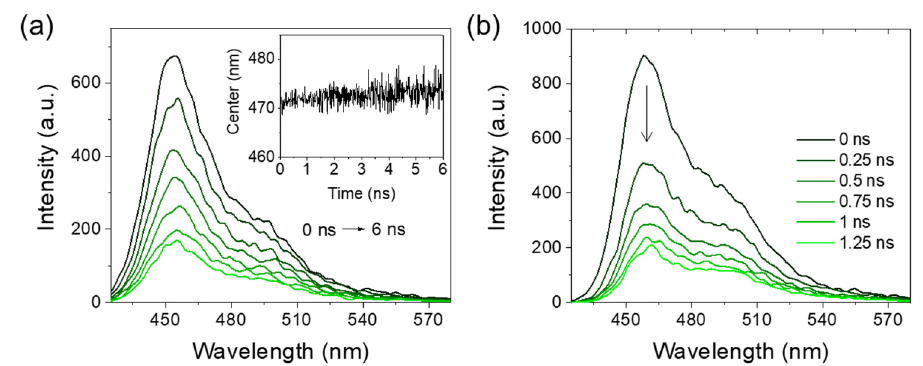
Figure 4. Time-resolved emission spectra (TRES) of ( a ) Al 2 O 3 :OHCCA free and ( b ) Al 2 O 3 :OHCCA agg . The inset of ( a ) shows the first moment (center wavelength weighted by fluorescence intensity) of TRES as a function of time. The excitation wavelength was 400 nm.